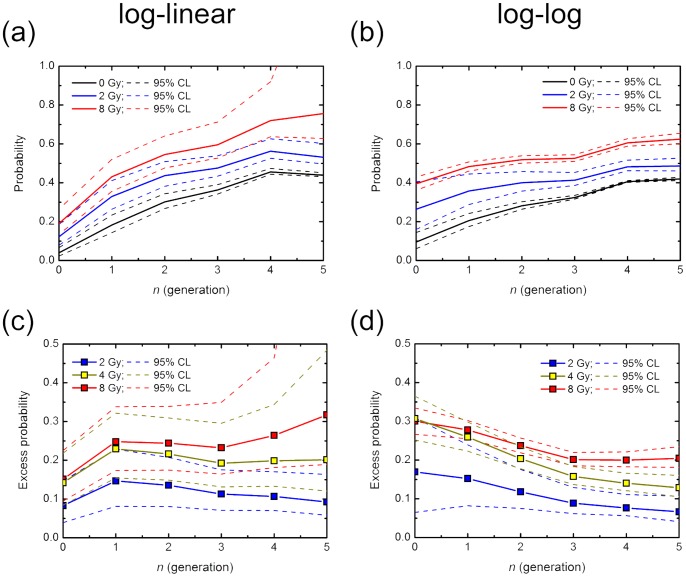
Reproductive cell death probability P1 (0, 2 and 8 Gy) and the excess P1 (2, 4 and 8 Gy) at 0 to 5 generations.
P1 was calculated with the simultaneous equations Equation 1, using the regression curves in Figure 4a–4f. IR-induced excess of P1 was estimated by P1 of abortive colonies derived from non-irradiated cells minus that from irradiated ones. Dotted lines show the 95% confidence limit.